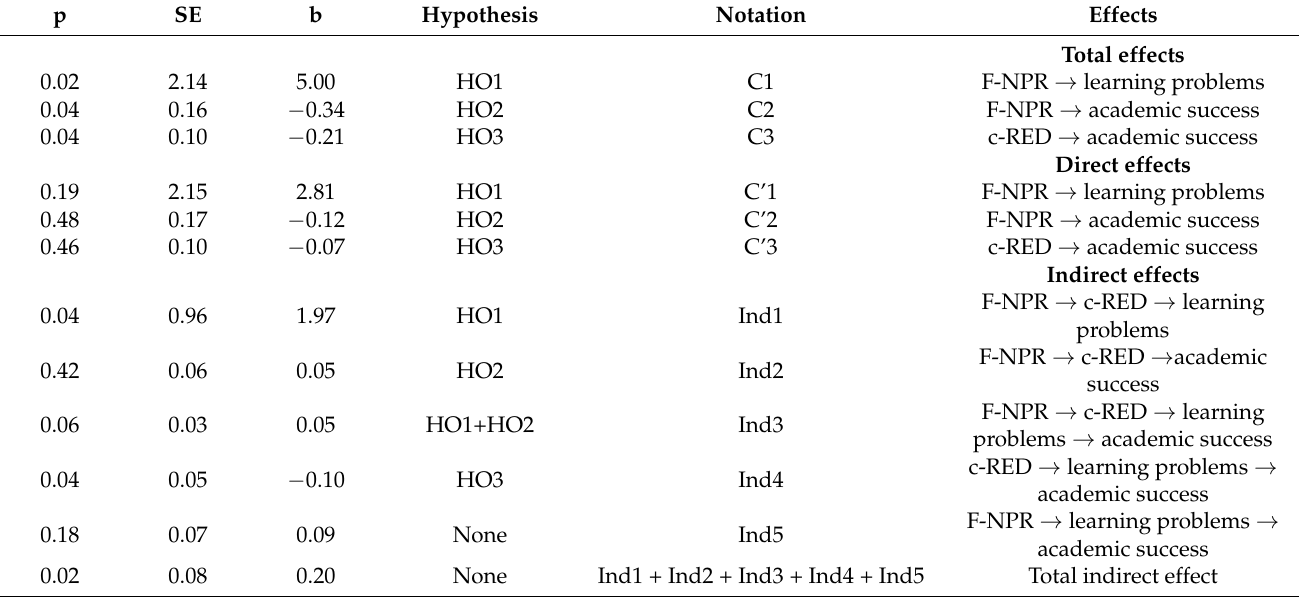
Table 2. Total, direct and indirect effects for the multiple mediation model.